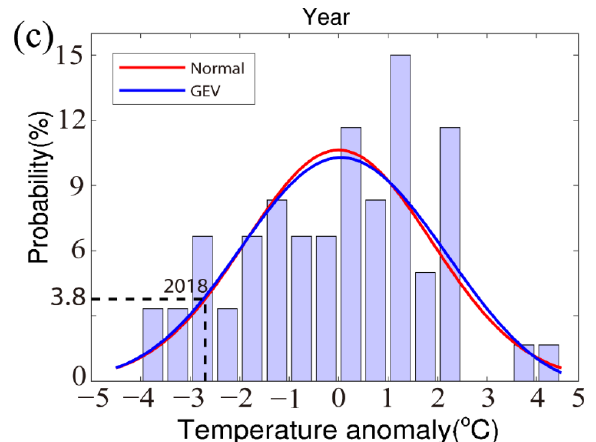
Figure 1. ( a ) Time series of the near-surface air temperature anomaly averaged over China for January from 1959 to 2018 using gauged data (red curve with hollow circle; units: °C; the green and black straight lines are the trend lines of recent 18 years ( − 0.012 °C /year) and 60 years (0.023 °C /year), respectively; the horizontal dashed line is − 1.42 °C, corresponding to a − 1.25 standard deviation threshold). ( b ) Same as (a) but for late (21–31) January. The trends in the last 18 and 60 years are − 0.032 °C /year and 0.012 °C /year, respectively, and the horizontal dashed line is − 2.35 °C. ( c ) Probability density functions (PDFs) of surface temperature anomalies in late January 1959–2018 (the red and blue solid curves are a normal and a generalized extreme value (GEV) fits, respectively). The anomalies are relative to the 1959–2018 mean. Atmosphere 2020 , 11 , 215